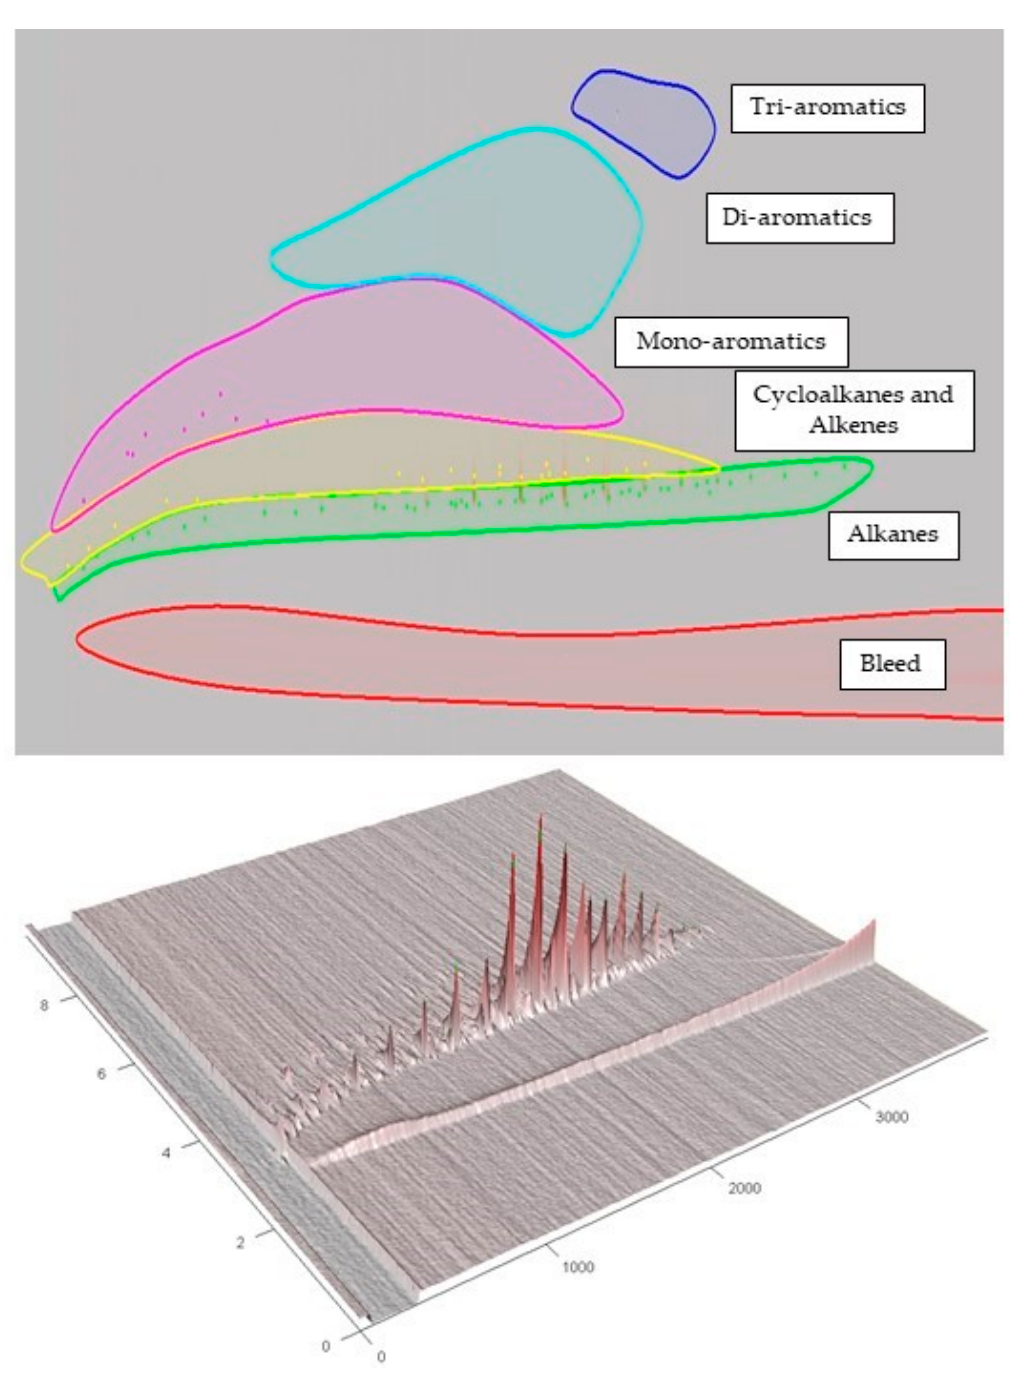
Figure 11. Average sample after the spontaneous deactivation.